Question: Identify the chart type used in this figure.
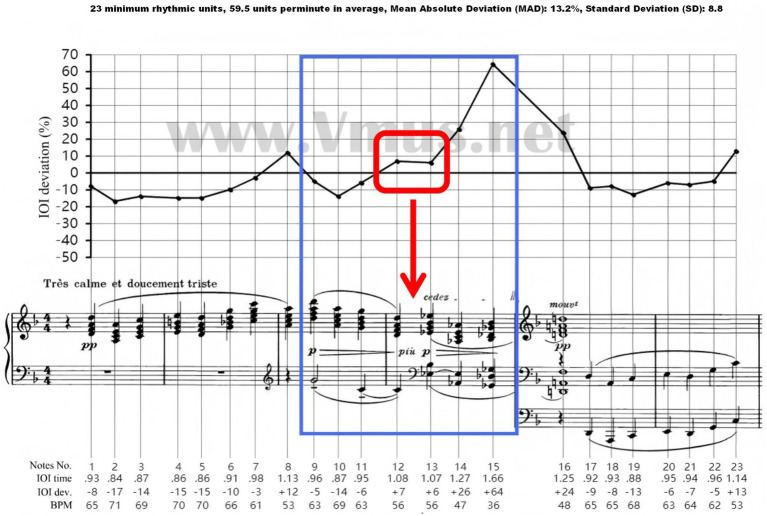
Answer: line